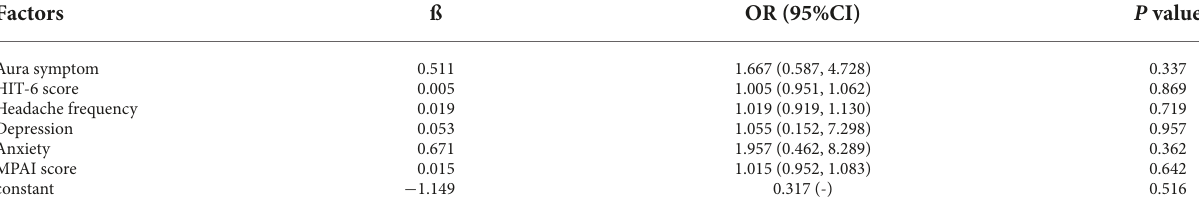
TABLE 5 Multivariate logistic regression analysis of factors associated with sleep quality in male migraine patients. Factors